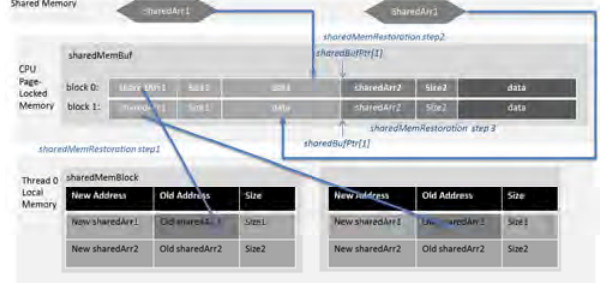
Fig. 13. Process Layout of Shared Memory